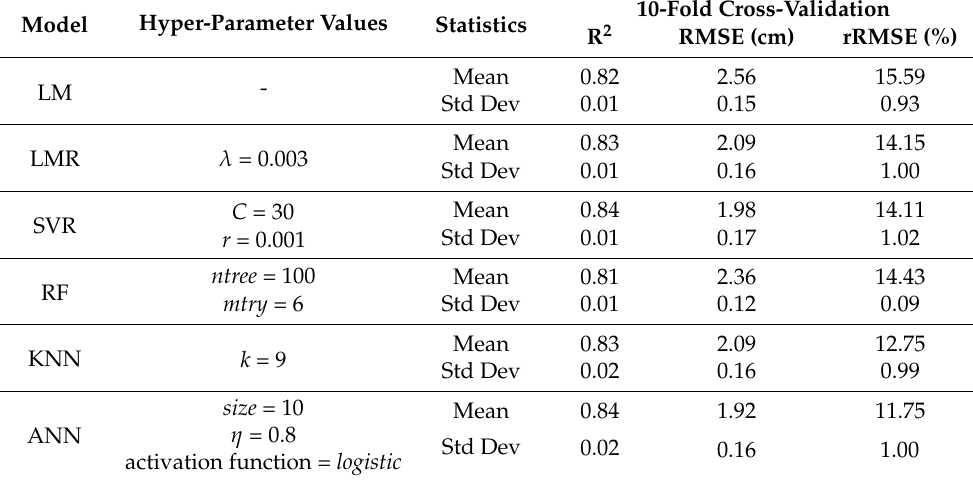
Table 5. Summary of hyper-parameter tuning and accuracy assessment results in cross-validation for different regression algorithms.